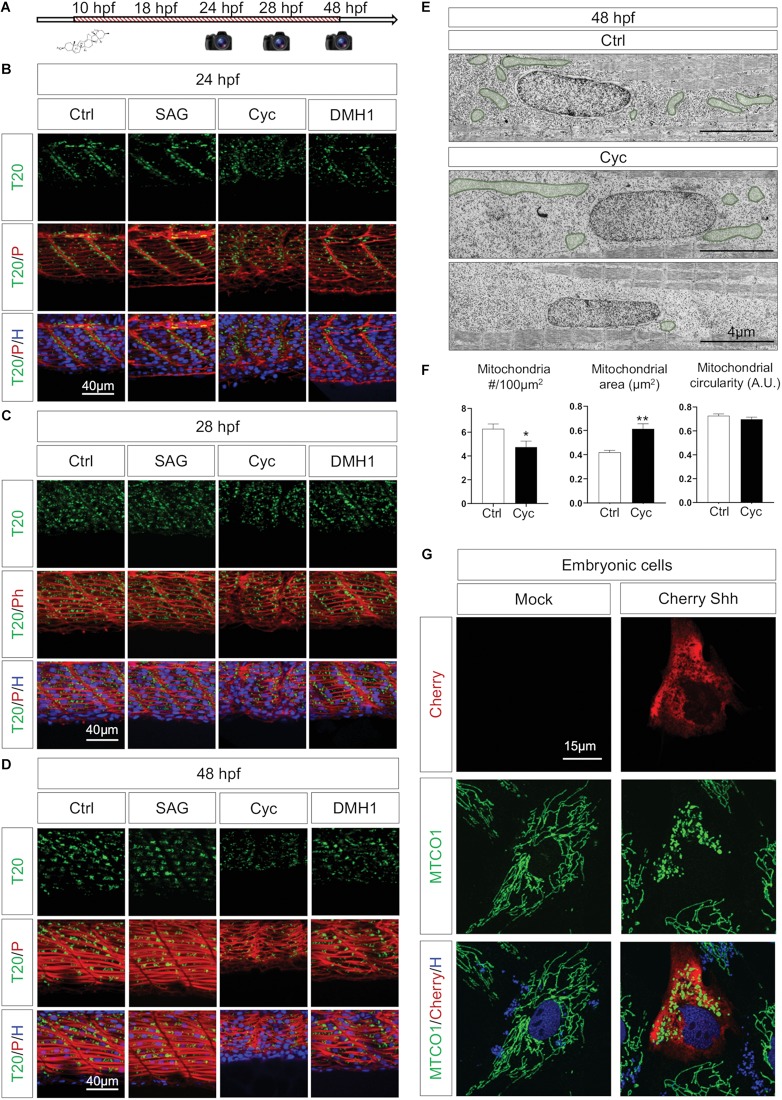
Shh signaling synchronizes tissue formation and mitochondria network maturation. (A) Pharmacological experiments design: agents were administered at 10 hpf, images captured at 24, 28, and 48 hpf. (B–D) Confocal imaging of mitochondrial network (Tomm20, T20; green) counterstained with Phalloidin (P; red) and Hoescht (H; blue) after administration of pharmacological agents to activate Shh signaling (SAG), inhibit Shh signaling (Cyclopamine, Cyc) or antagonize BMP signaling (DMH1) at 24 hpf (B), 28 hpf (C), and 48 hpf (D) in embryos submitted to the different drugs and in controls (Ctrl). (E) Electron micrographs of longitudinal sections at 48 hpf in Ctrl and Cyc treated embryo. Mitochondria are overlaid in green. (F) Quantification of mitochondria number, mean area and circularity at 48 hpf in Cyc treated embryos and Ctrl from longitudinal electron micrographs (n = 5 micrographs per group). (G) Confocal imaging of embryonic cells cultured from 10 hpf bud stage embryos either transfected with empty vector (Mock) or expressing Cherry-Shh. Mitochondria network is labeled with the component of complex IV MTCO1 (green), counterstained by Cherry (red) and Hoechst (H; blue). Bars are mean ± SEM. ∗P < 0.05, ∗∗P < 0.01, unpaired T-test. See Supplementary Figure S7.